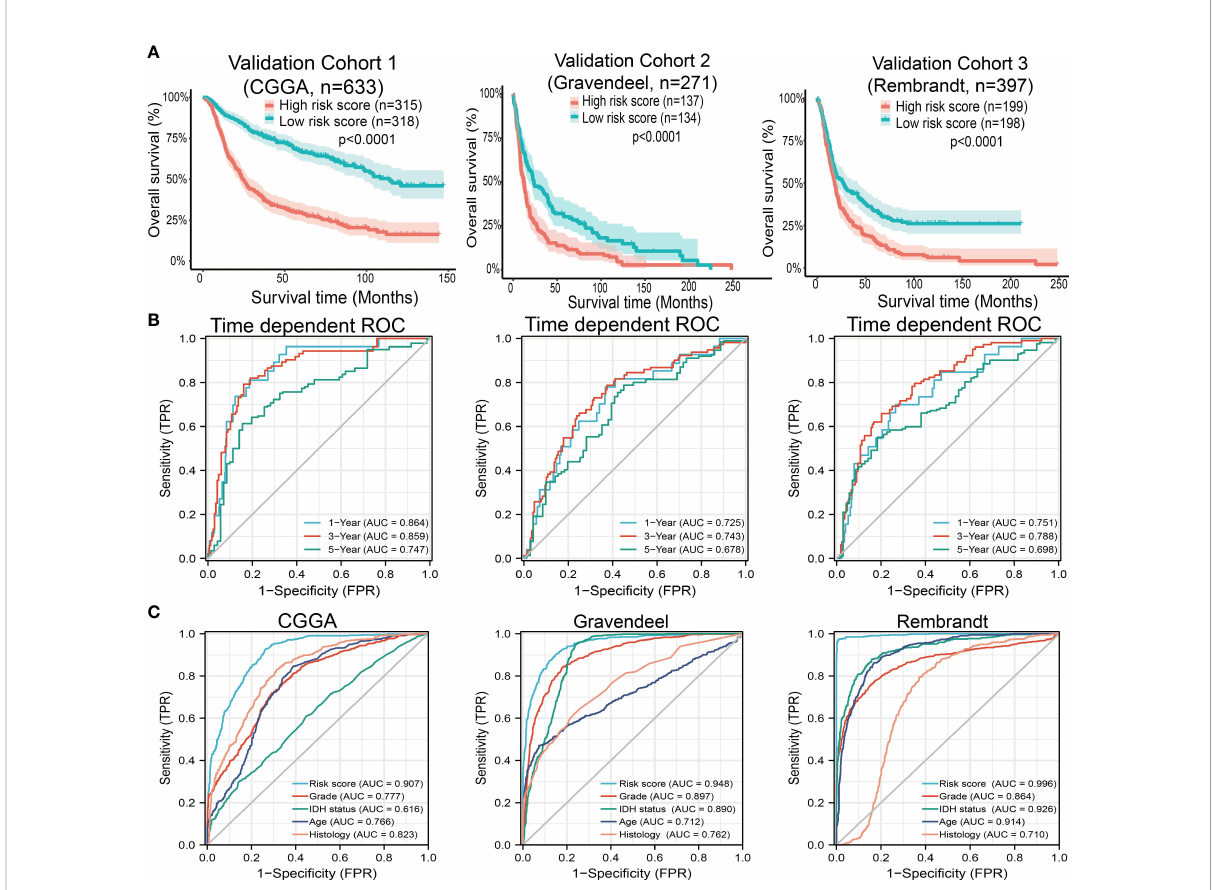
FIGURE 10 Predictive powers for prognosis of this nomogram. (A) Kaplan-Meier survival validation in the CGGA, Gravendeel, and Rembrandt cohorts. Patients with high-risk scores had a poor outcomes in terms of overall survival. (B) ROC curves showed the AUC of this nomogram for predicting 1-, 3- and 5-year survival of glioma patients, respectively. (C) ROC curves comparing prognostic accuracy of risk score with clinical histology, grade, IDH status, and age in external validation cohorts. AUC, area under the curve; ROC, receiver operating